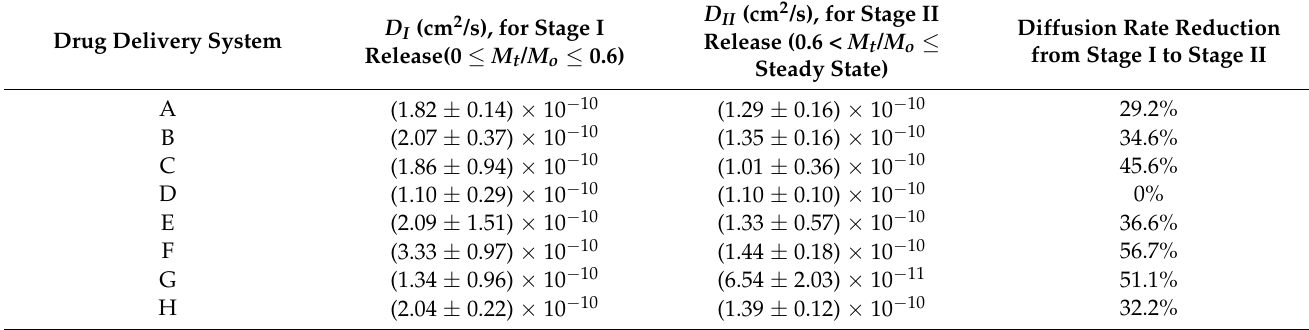
Table 3. Estimations of diffusion coefficients using a combination of analytical and numerical